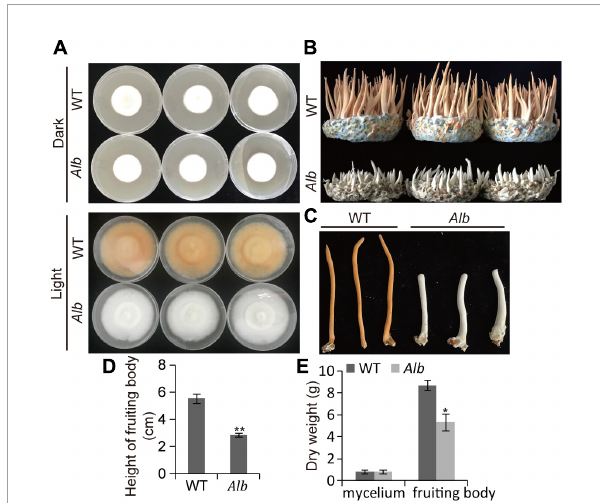
FIGURE1 Phenotype analysis of Alb mutant. (A) Color change of the mycelia in WT and Alb under dark and light treatment; (B) fruiting body growth of WT and Alb ; (C,D) height of fruiting bodies in WT and Alb ; (E) dry weight of the mycelia and fruiting bodies in WT and Alb . WT, wild-type C. militaris ; Alb , albino mutant. One and two asterisks denote significance relative to WT (Student’s t -test; * p < 0.05 and ** p <